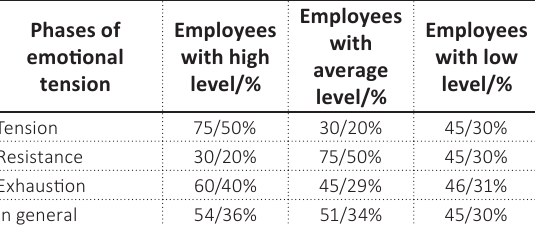
Table 3. The level of professional emotional